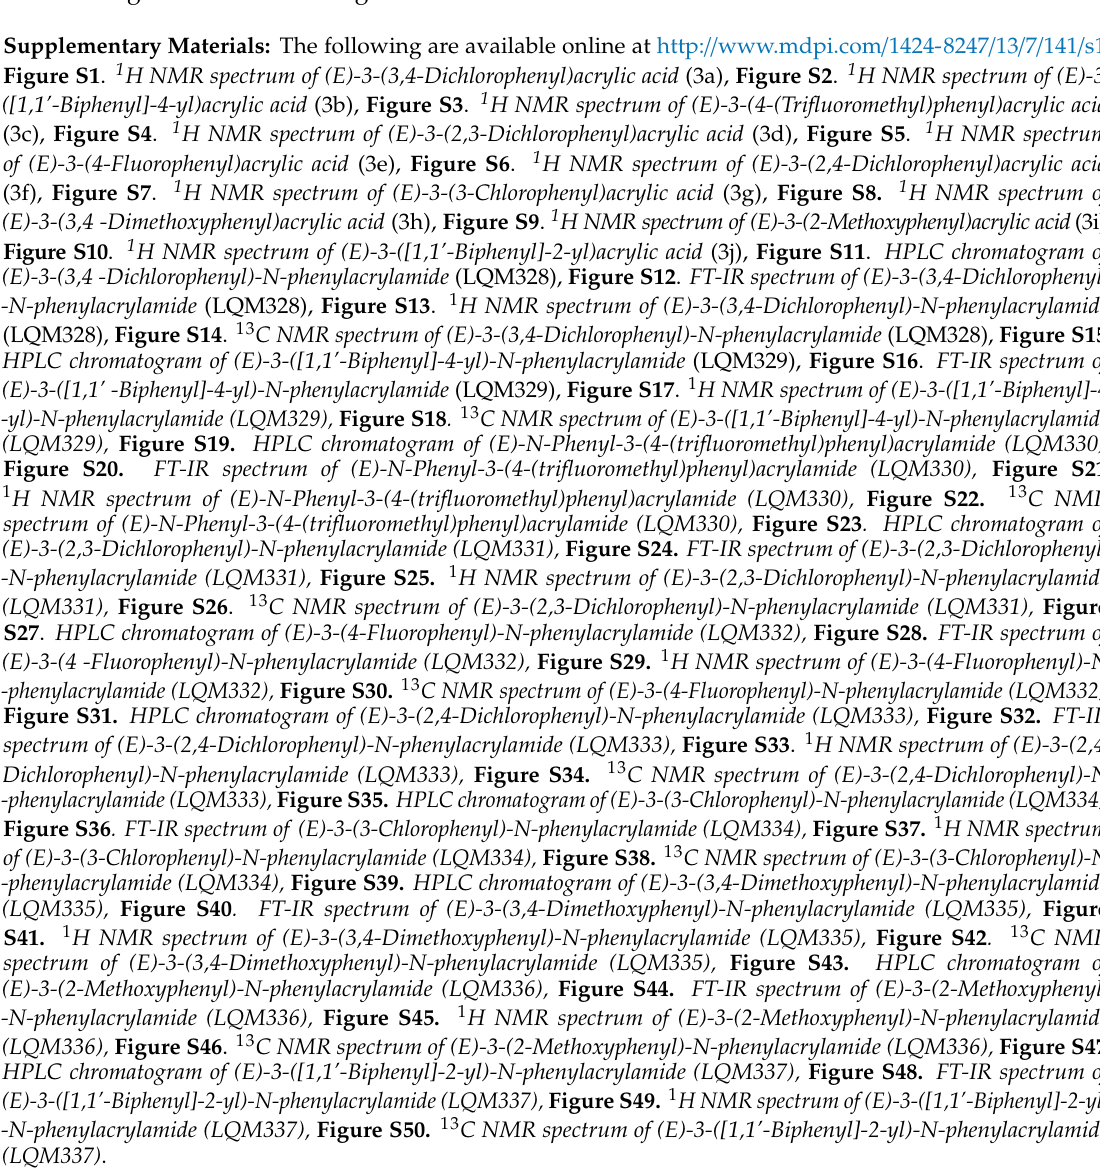
Figure S1 . 1 H NMR spectrum of (E)-3-(3,4-Dichlorophenyl)acrylic acid (3a), Figure S2 . 1 H NMR spectrum of (E)-3- ([1,1’-Biphenyl]-4-yl)acrylic acid (3b), Figure S3 . 1 H NMR spectrum of (E)-3-(4-(Trifluoromethyl)phenyl)acrylic acid (3c), Figure S4 . 1 H NMR spectrum of (E)-3-(2,3-Dichlorophenyl)acrylic acid (3d), Figure S5 . 1 H NMR spectrum of (E)-3-(4-Fluorophenyl)acrylic acid (3e), Figure S6 . 1 H NMR spectrum of (E)-3-(2,4-Dichlorophenyl)acrylic acid (3f), Figure S7 . 1 H NMR spectrum of (E)-3-(3-Chlorophenyl)acrylic acid (3g), Figure S8. 1 H NMR spectrum of (E)-3-(3,4 -Dimethoxyphenyl)acrylic acid (3h), Figure S9 . 1 H NMR spectrum of (E)-3-(2-Methoxyphenyl)acrylic acid (3i), Figure S10 . 1 H NMR spectrum of (E)-3-([1,1’-Biphenyl]-2-yl)acrylic acid (3j), Figure S11 . HPLC chromatogram of (E)-3-(3,4 -Dichlorophenyl)-N-phenylacrylamide (LQM328), Figure S12 . FT-IR spectrum of (E)-3-(3,4-Dichlorophenyl) -N-phenylacrylamide (LQM328), Figure S13 . 1 H NMR spectrum of (E)-3-(3,4-Dichlorophenyl)-N-phenylacrylamide (LQM328), Figure S14 . 13 C NMR spectrum of (E)-3-(3,4-Dichlorophenyl)-N-phenylacrylamide (LQM328), Figure S15. HPLC chromatogram of (E)-3-([1,1’-Biphenyl]-4-yl)-N-phenylacrylamide (LQM329), Figure S16 . FT-IR spectrum of (E)-3-([1,1’ -Biphenyl]-4-yl)-N-phenylacrylamide (LQM329), Figure S17 . 1 H NMR spectrum of (E)-3-([1,1’-Biphenyl]-4 -yl)-N-phenylacrylamide (LQM329), Figure S18 . 13 C NMR spectrum of (E)-3-([1,1’-Biphenyl]-4-yl)-N-phenylacrylamide (LQM329), Figure S19. HPLC chromatogram of (E)-N-Phenyl-3-(4-(trifluoromethyl)phenyl)acrylamide (LQM330), Figure S20. FT-IR spectrum of (E)-N-Phenyl-3-(4-(trifluoromethyl)phenyl)acrylamide (LQM330), Figure S21. 1 H NMR spectrum of (E)-N-Phenyl-3-(4-(trifluoromethyl)phenyl)acrylamide (LQM330), Figure S22. 13 C NMR spectrum of (E)-N-Phenyl-3-(4-(trifluoromethyl)phenyl)acrylamide (LQM330), Figure S23 . HPLC chromatogram of (E)-3-(2,3-Dichlorophenyl)-N-phenylacrylamide (LQM331), Figure S24. FT-IR spectrum of (E)-3-(2,3-Dichlorophenyl) -N-phenylacrylamide (LQM331), Figure S25. 1 H NMR spectrum of (E)-3-(2,3-Dichlorophenyl)-N-phenylacrylamide (LQM331), Figure S26 . 13 C NMR spectrum of (E)-3-(2,3-Dichlorophenyl)-N-phenylacrylamide (LQM331), Figure S27 . HPLC chromatogram of (E)-3-(4-Fluorophenyl)-N-phenylacrylamide (LQM332), Figure S28. FT-IR spectrum of (E)-3-(4 -Fluorophenyl)-N-phenylacrylamide (LQM332), Figure S29. 1 H NMR spectrum of (E)-3-(4-Fluorophenyl)-N -phenylacrylamide (LQM332), Figure S30. 13 C NMR spectrum of (E)-3-(4-Fluorophenyl)-N-phenylacrylamide (LQM332), Figure S31. HPLC chromatogram of (E)-3-(2,4-Dichlorophenyl)-N-phenylacrylamide (LQM333), Figure S32. FT-IR spectrum of (E)-3-(2,4-Dichlorophenyl)-N-phenylacrylamide (LQM333), Figure S33 . 1 H NMR spectrum of (E)-3-(2,4- Dichlorophenyl)-N-phenylacrylamide (LQM333), Figure S34. 13 C NMR spectrum of (E)-3-(2,4-Dichlorophenyl)-N -phenylacrylamide (LQM333), Figure S35. HPLC chromatogram of (E)-3-(3-Chlorophenyl)-N-phenylacrylamide (LQM334), Figure S36 . FT-IR spectrum of (E)-3-(3-Chlorophenyl)-N-phenylacrylamide (LQM334), Figure S37. 1 H NMR spectrum of (E)-3-(3-Chlorophenyl)-N-phenylacrylamide (LQM334), Figure S38. 13 C NMR spectrum of (E)-3-(3-Chlorophenyl)-N -phenylacrylamide (LQM334), Figure S39. HPLC chromatogram of (E)-3-(3,4-Dimethoxyphenyl)-N-phenylacrylamide (LQM335), Figure S40 . FT-IR spectrum of (E)-3-(3,4-Dimethoxyphenyl)-N-phenylacrylamide (LQM335), Figure S41. 1 H NMR spectrum of (E)-3-(3,4-Dimethoxyphenyl)-N-phenylacrylamide (LQM335), Figure S42 . 13 C NMR spectrum of (E)-3-(3,4-Dimethoxyphenyl)-N-phenylacrylamide (LQM335), Figure S43. HPLC chromatogram of (E)-3-(2-Methoxyphenyl)-N-phenylacrylamide (LQM336), Figure S44. FT-IR spectrum of (E)-3-(2-Methoxyphenyl) -N-phenylacrylamide (LQM336), Figure S45. 1 H NMR spectrum of (E)-3-(2-Methoxyphenyl)-N-phenylacrylamide (LQM336), Figure S46 . 13 C NMR spectrum of (E)-3-(2-Methoxyphenyl)-N-phenylacrylamide (LQM336), Figure S47. HPLC chromatogram of (E)-3-([1,1’-Biphenyl]-2-yl)-N-phenylacrylamide (LQM337), Figure S48. FT-IR spectrum of (E)-3-([1,1’-Biphenyl]-2-yl)-N-phenylacrylamide (LQM337), Figure S49. 1 H NMR spectrum of (E)-3-([1,1’-Biphenyl]-2-yl) -N-phenylacrylamide (LQM337), Figure S50. 13 C NMR spectrum of (E)-3-([1,1’-Biphenyl]-2-yl)-N-phenylacrylamide (LQM337)